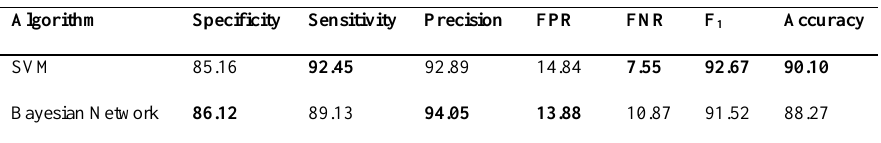
Table 2. Comparison of performance of SVM and Bayesian network algorithms through using training dataset for prediction of Sex in PD (%)